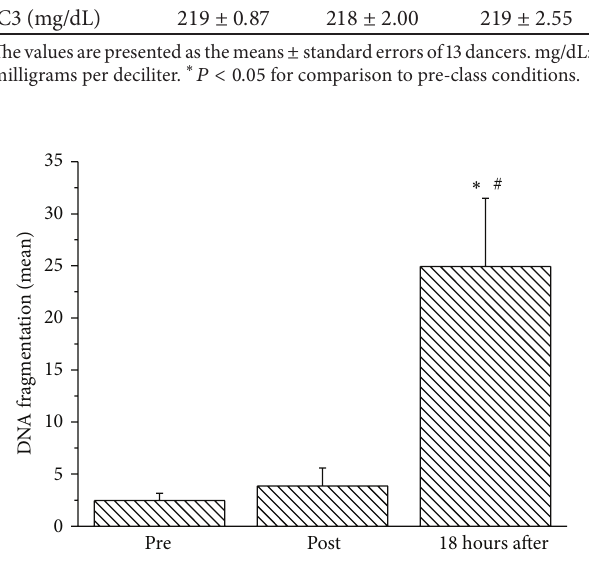
Figure 2: Neutrophil DNA fragmentation (%) in ballet dancers determined before, immediately after, and 18 hours after a ballet class. The values are presented as the mean ± standard error of 13 dancers. ∗ 𝑃 < 0.05 for comparison to preclass and # 𝑃 < 0.05 for comparison to immediately after ballet class.